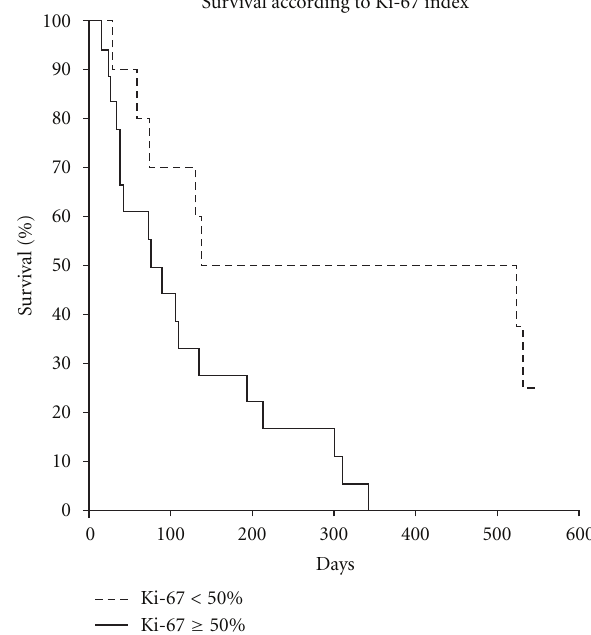
Figure 1: Kaplan-Meier survival curves for patients with Ki-67 index < 50% versus ≥